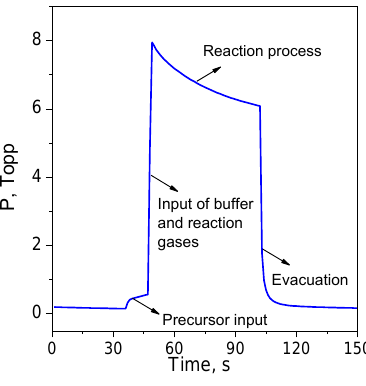
Figure 1. Change of the pressure during the deposition cycle.